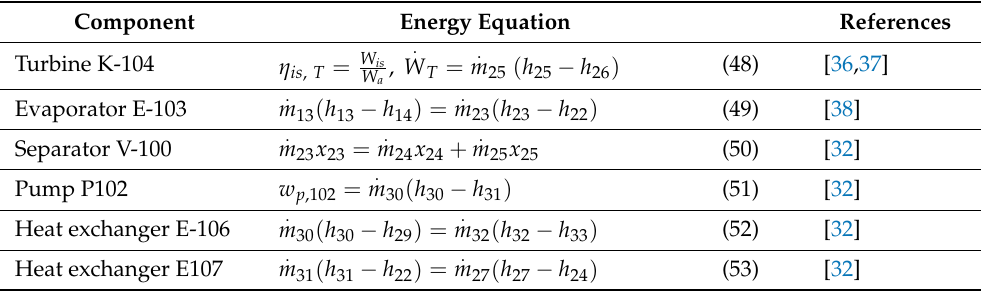
Table 3. Energy equations of main components of